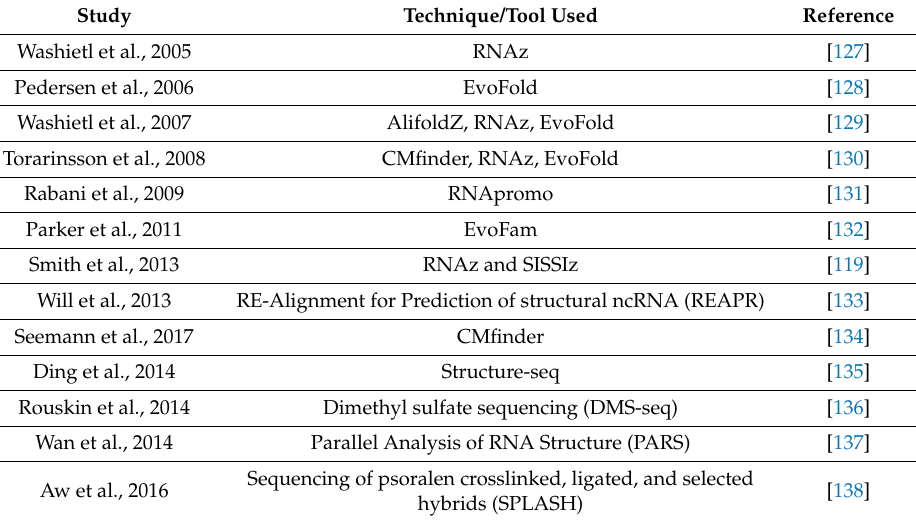
Table 6. RNA secondary structure conservation-based